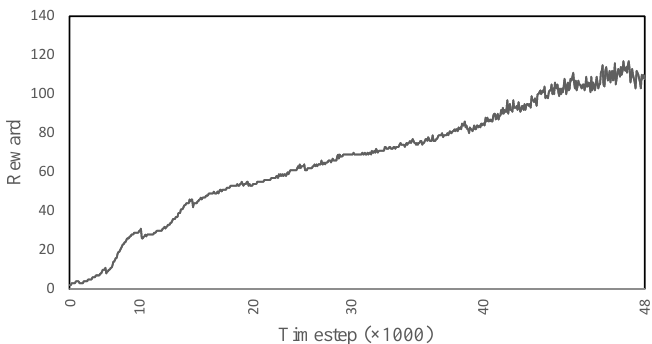
Figure 9. The reward obtained during the learning process of the human musculoskeletal model to ascend the